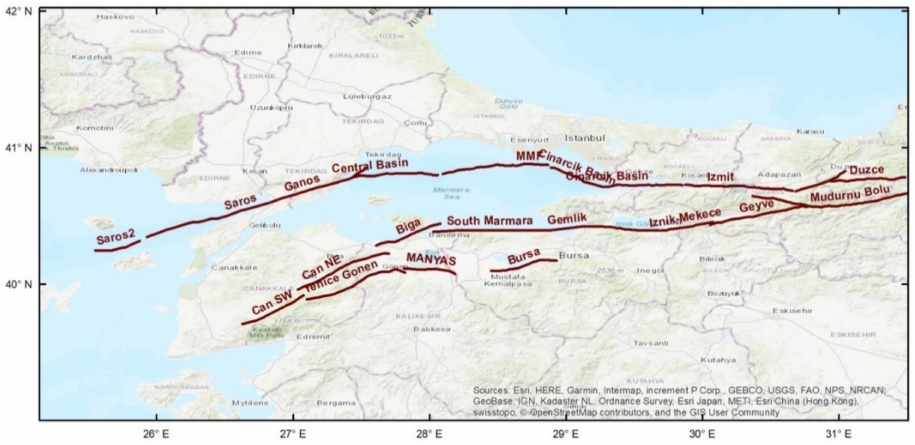
Figure 8. The fault source model developed in this study. The text indicates the segment